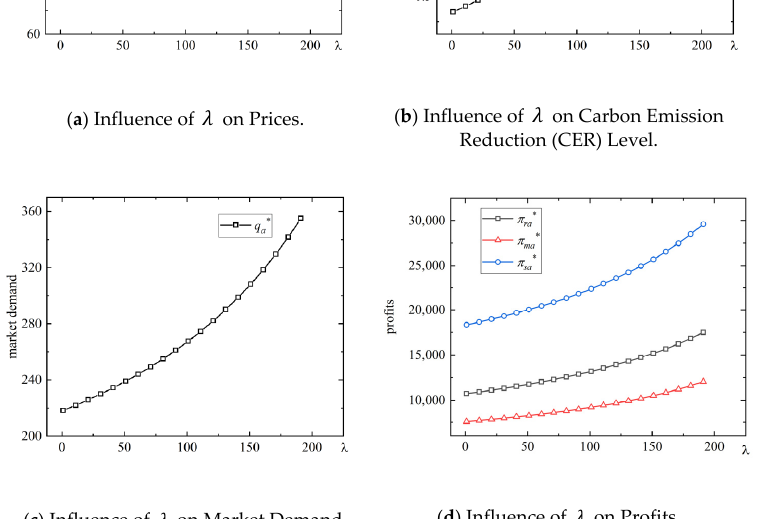
Figure 3. The Influence of Consumers’ Low Carbon Preference 𝜆 on Supply Chain Decision.